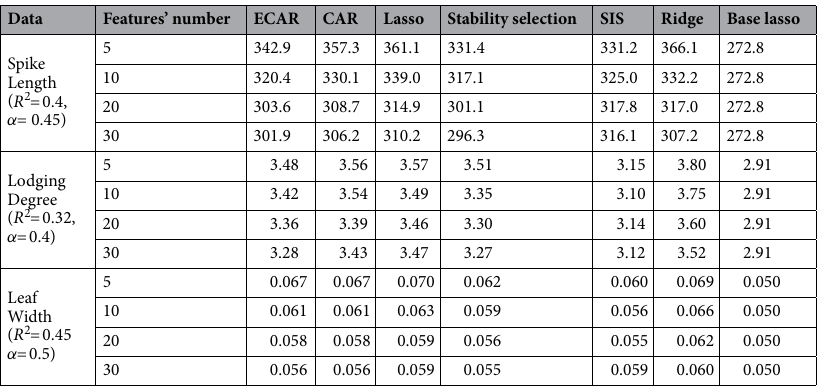
Table 1. Summary of the generalization performance of high-rank SNP features evaluated by lasso on the three datasets. Base lasso is the prediction performance of lasso on the test sets using all features as input. See the “Methods” section for further details.